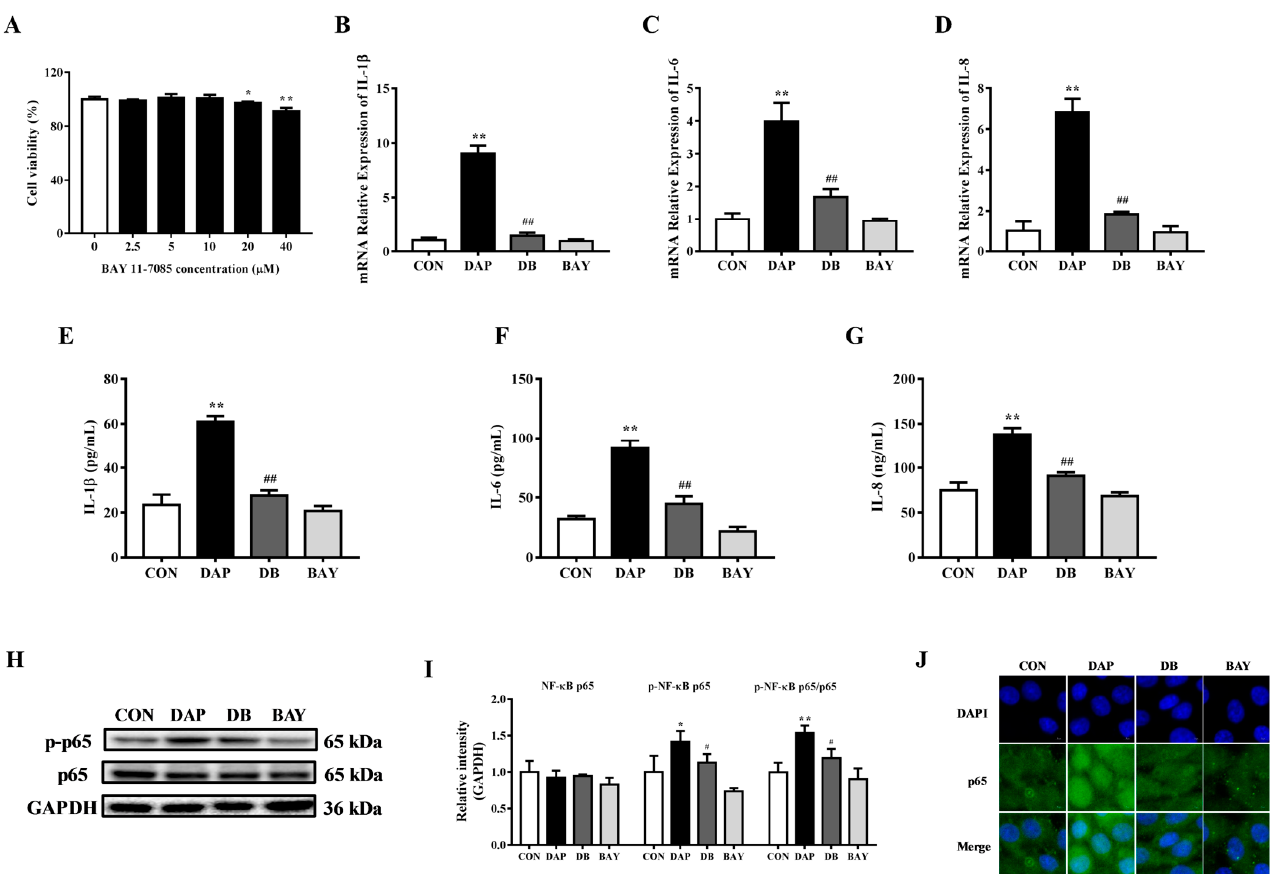
Figure 4. Effects of BAY 11-7085 on the inflammatory response induced by iE-DAP in BMECs. ( A ) Cell viability of BMECs treated with different concentration of BAY 11-7085. ( B – D ) Gene expression of inflammatory cytokines in BMECs treated with 1000 ng/mL iE-DAP for 12 h after 10 μ M BAY 11-7085 pretreatment for 1 h. ( E – G ) The concentration of inflammatory cytokines in culture supernatant of BMECs treated with iE-DAP after BAY 11-7085 pretreatment. ( H , I ) WB representative bands and quantitative results of NF- κ B signaling pathway-related proteins and ( J ) immunofluorescence results of NF- κ B p65 in BMECs treated with iE-DAP after BAY 11-7085 pretreatment. In the immunofluorescence results, the scale bar = 5 μ m. Results were shown as the mean ± SEM. * p < 0.05, ** p < 0.01, represent a significant difference compared with the control group. # p < 0.05, ## p < 0.01, represent a significant difference compared with the iE-DAP group. DB: BAY 11-7085 + iE-DAP group; BAY: BAY 11-7085 group.